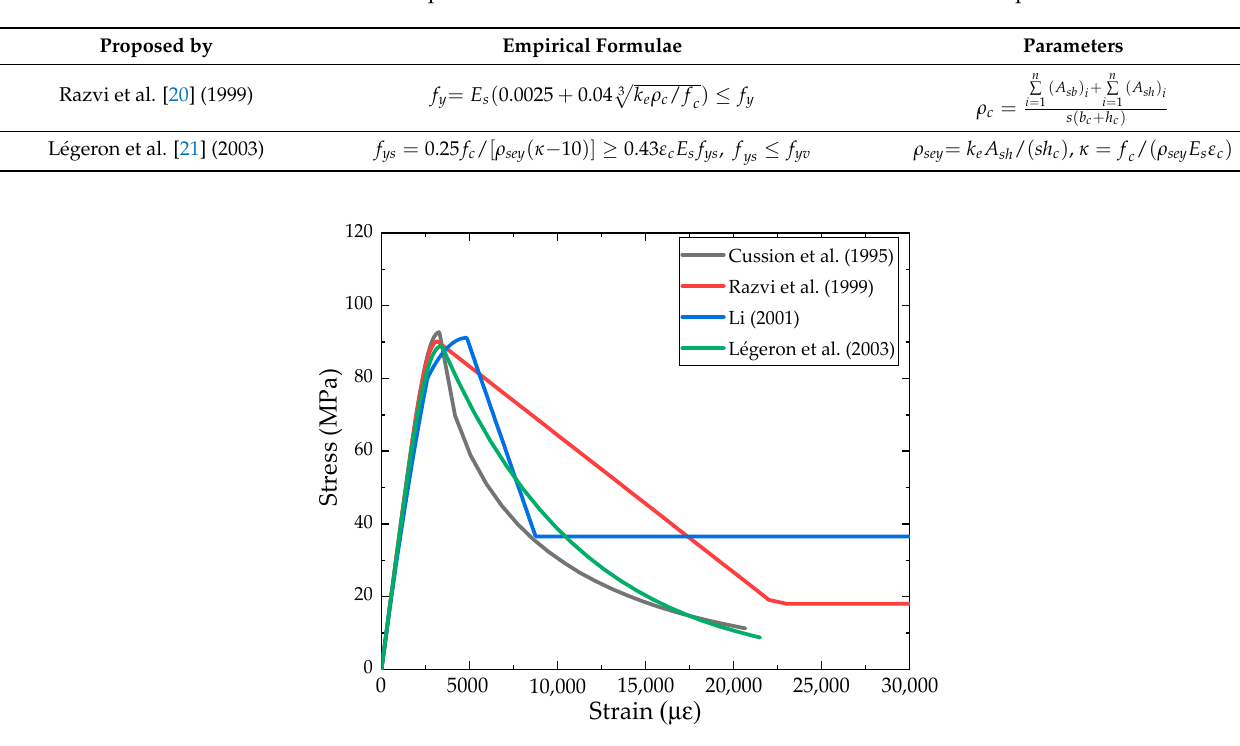
Table 2. Empirical formulae for ties strain when confined concrete is at peak stress.